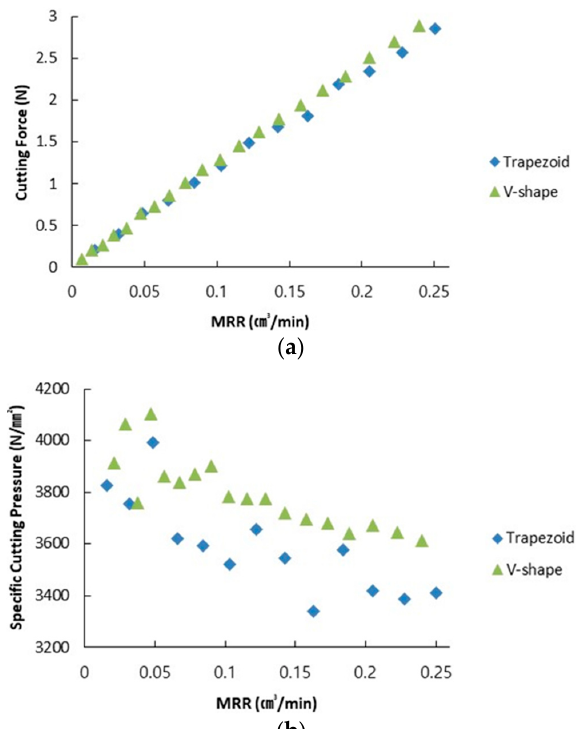
Figure 9. Measured cutting force and specific cutting pressure: ( a ) cutting force, ( b ) specific cutting pressure.